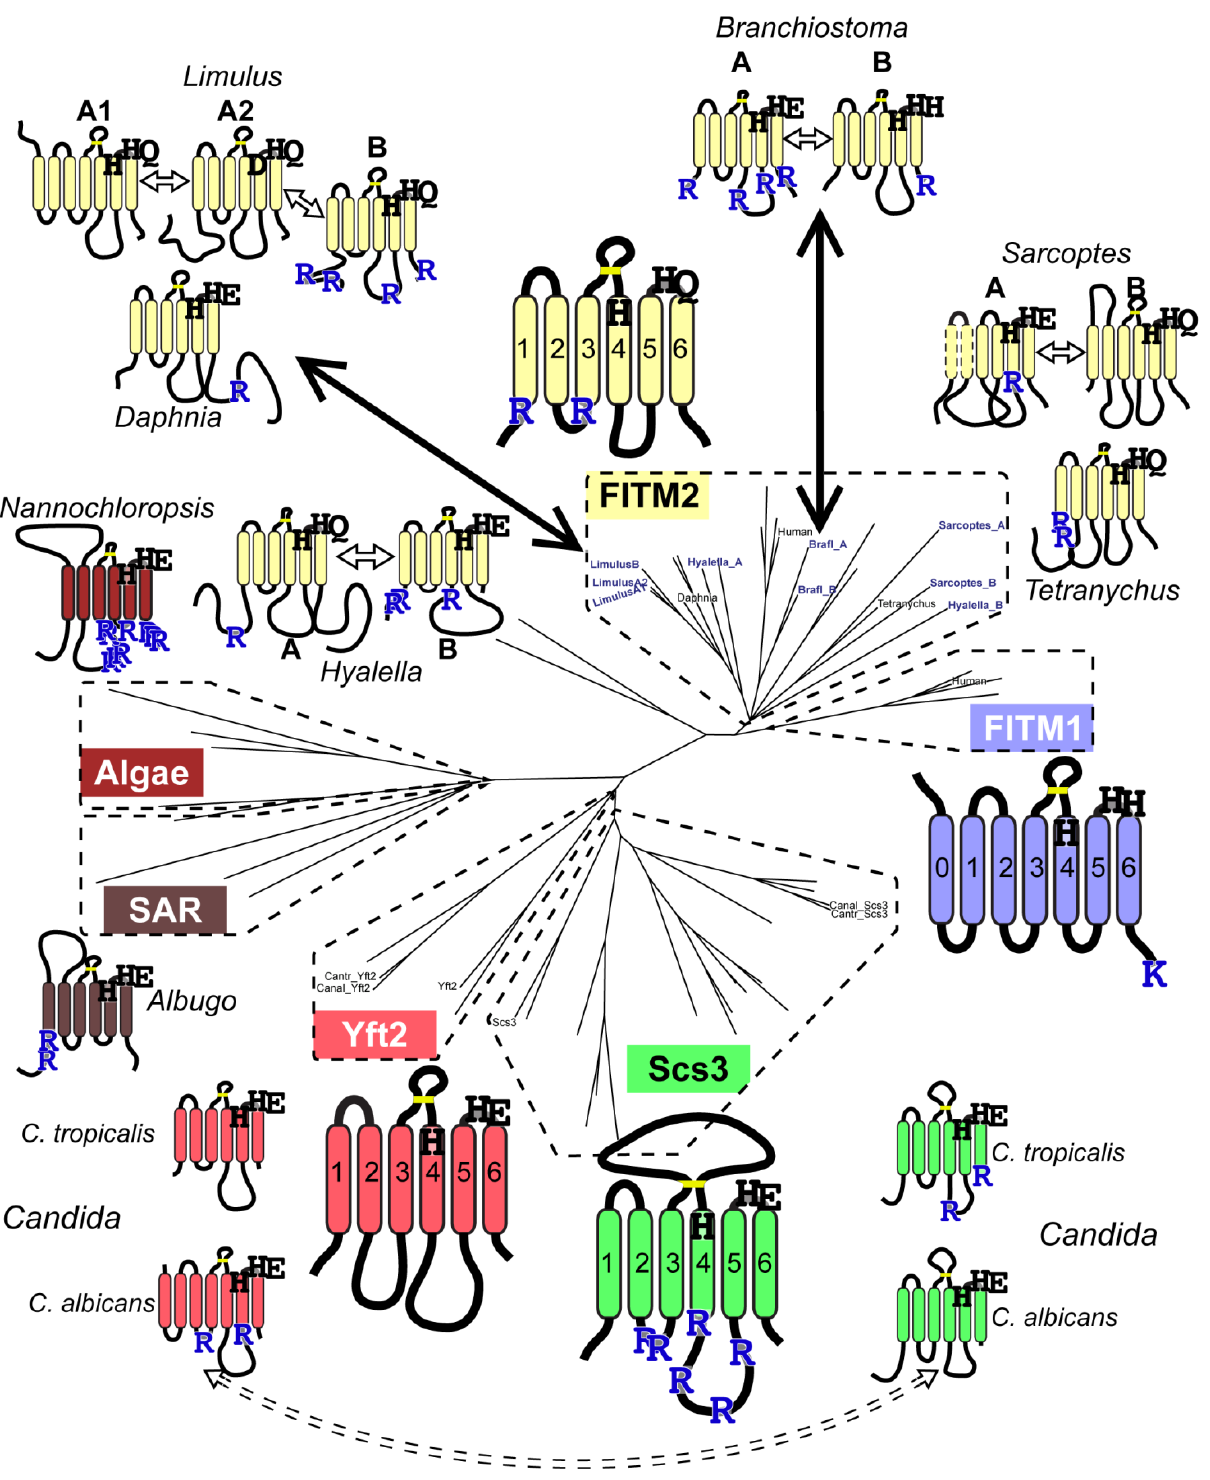
FIGURE 6: Catalytic triad residues and di-arginine motifs diverge at multiple duplications across FITM evolution . Sequence features of main FITMs and those in recent divergent duplications. Examples from the major groups of FITMs (FITM1 in vertebrates, FITM2 in animals, Yft2p and Scs3p in fungi) and from the two groups of FITMs in protists and algae are shown to indicate the residues that align with the cata- lytic triad in LPTs and their ER retention motifs (R = diarginine, K = KK(x)xx). Also shown are the recently duplicated sequences and their closest related sequences, as described in the text, colour coded to indicate what group of FITMs they belong to. Other features indicated: size of loops between TMDs, disulphide bridge predicted for loop 3/4 (yellow bar), and the position of each protein on the overall tree of FITMs (see Figure S2). Sequences from Candida species C. tropicalis and C. albicans show high levels of conservation, but the di-arginine motifs are swapped (see